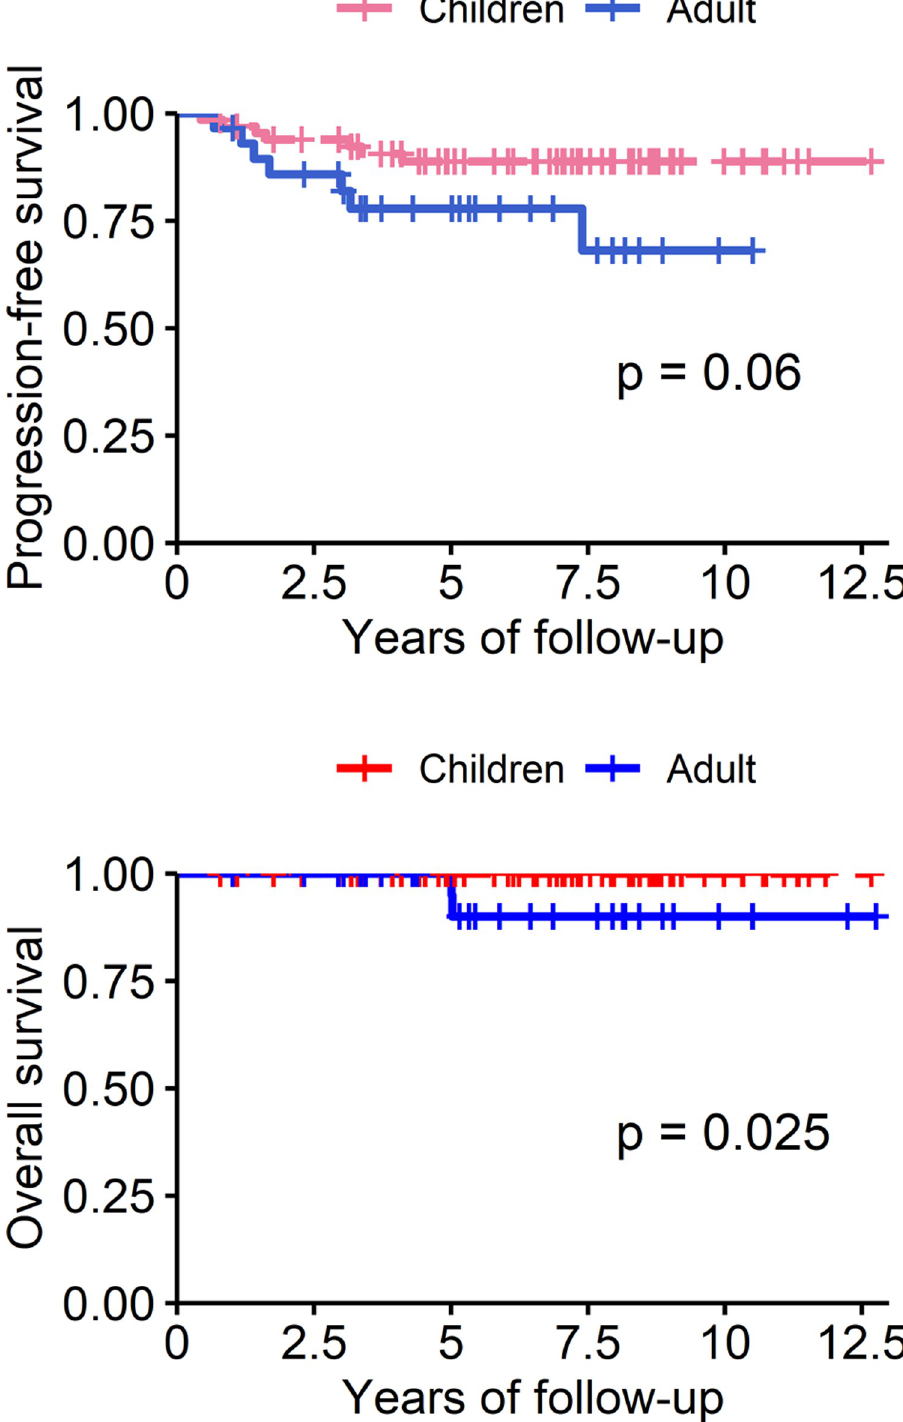
Fig 4. Progression-free survival and overall survival of adult and pediatric patients with intracranial germinoma.